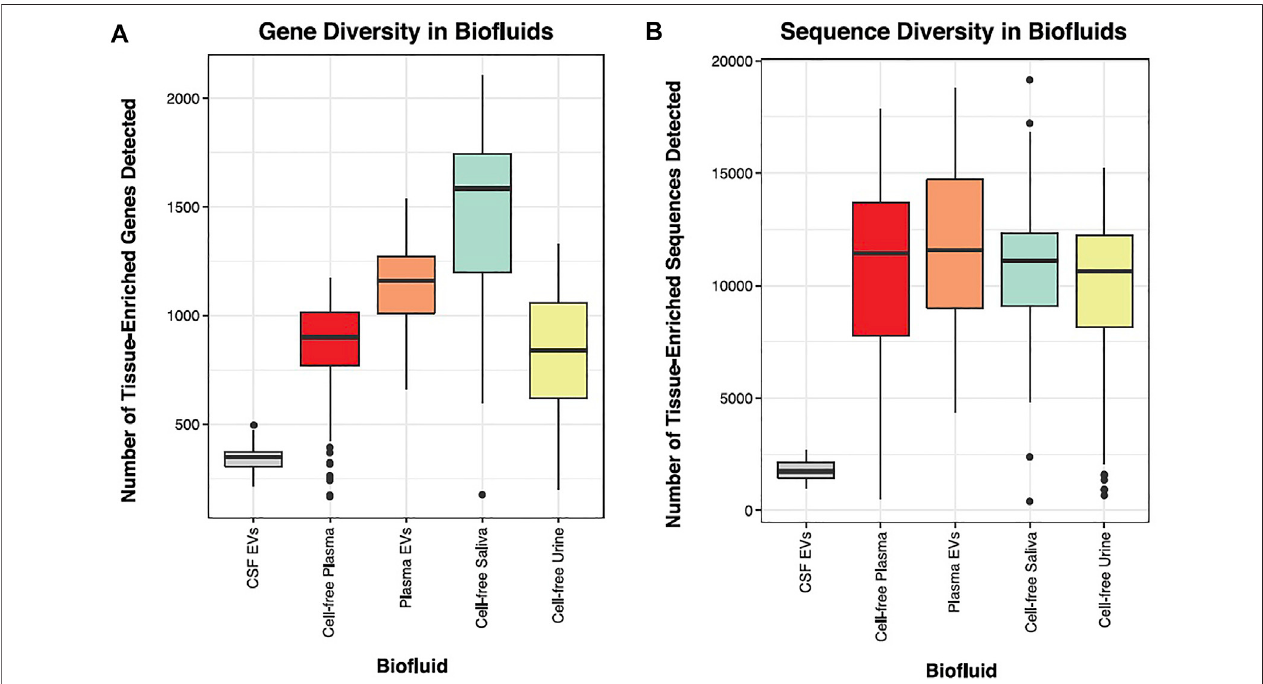
FIGURE 7 | Bio fl uid Diversity. Panels (A, B) display the number of tissue-enriched genes identi fi ed in the small RNA sequenced data. The parent tissue-elevated genes that were detected in each bio fl uid are displayed in Panel (A) . CSF had the lowest number of tissue-elevated genes and saliva had the highest. Panel (B) displays the number of tissue-elevated sequences that were detected in each bio fl